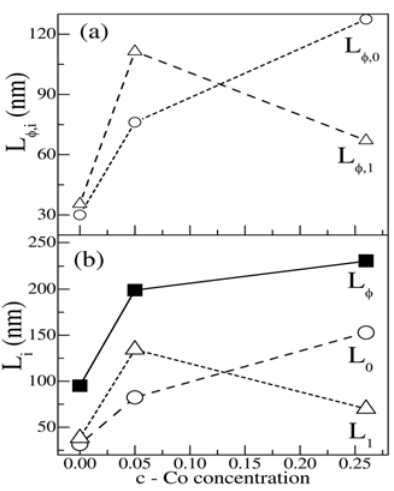
Fig. 7. Parameters used in Eq.2 to fit the MC curves observed (fig.6) in thin films of pure Bi (c=0), Bi/Co/Bi trilayer (c=0.05) and [Co/Bi] 10 multilayer (c=0.26). (a) WL ( L (cid:2),0 ) and WAL ( L (cid:2),1 ) lengths as a function of Co concentration. (b) WL ( L 0 ) and WAL ( L 1 ) correction lengths to a common L (cid:2) length on every c- Co. Lines are guides to the